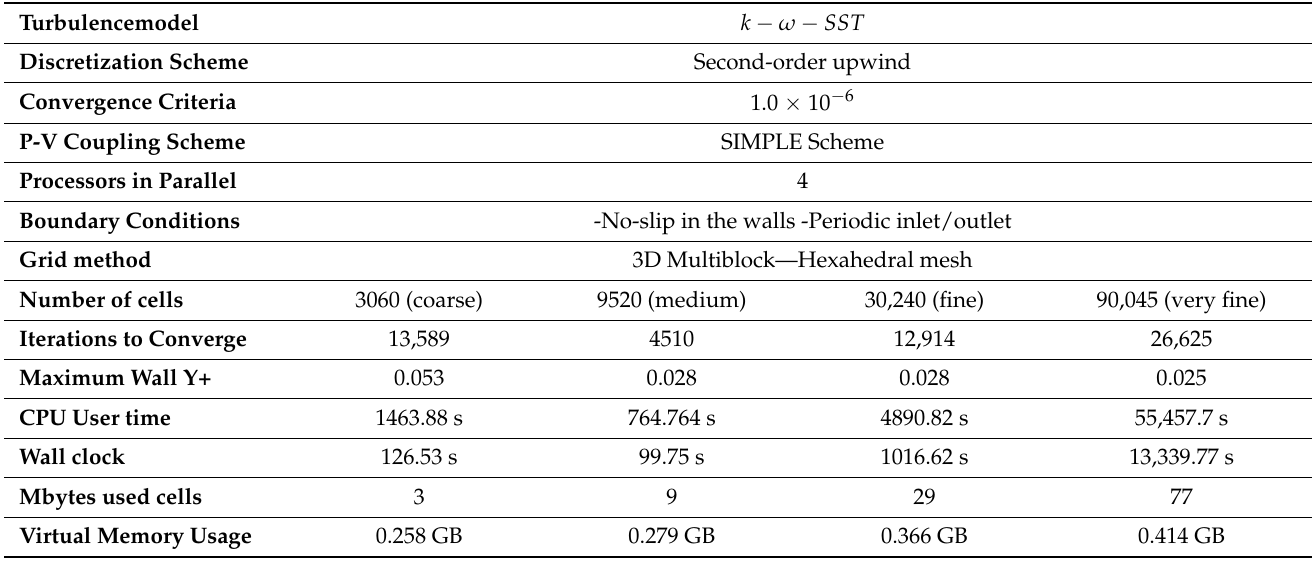
Table 4. Comparative table of mesh independency tests.